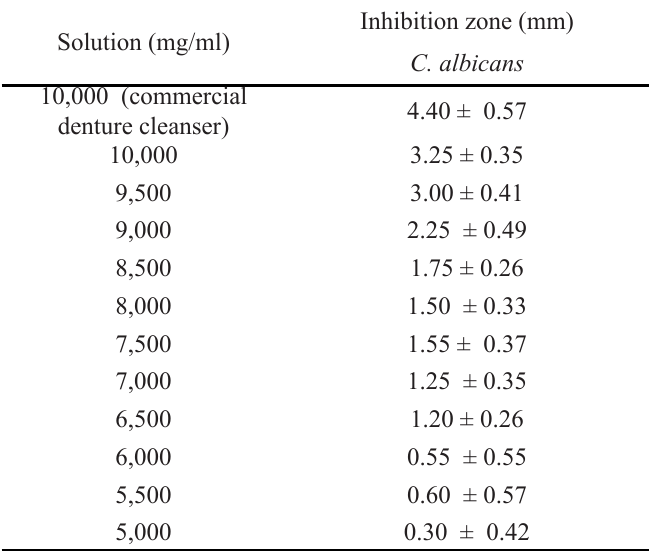
Table 1: Zone of inhibition of a standard isolate of C. albicans (ATCC 90028) against a solution of denture cleanser tablet and different concentrations of P. betle.